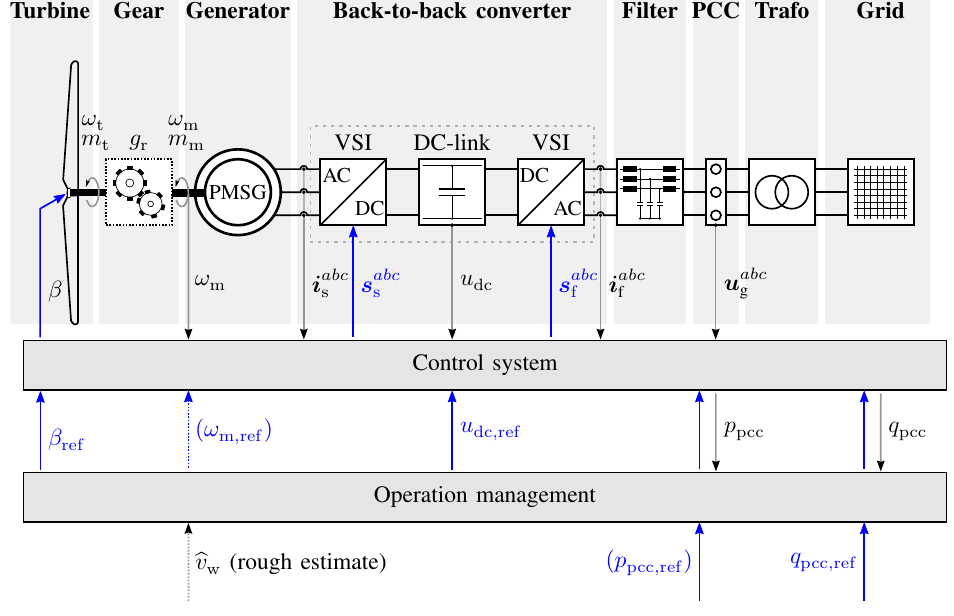
Figure 1. Overview of the core components of a